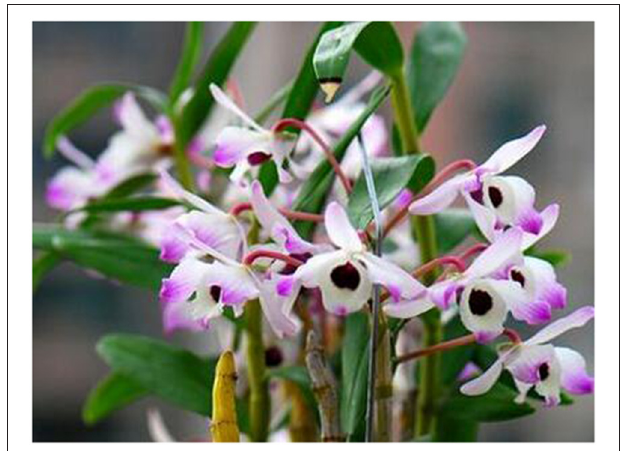
FIGURE 1 | The picture of DNL.